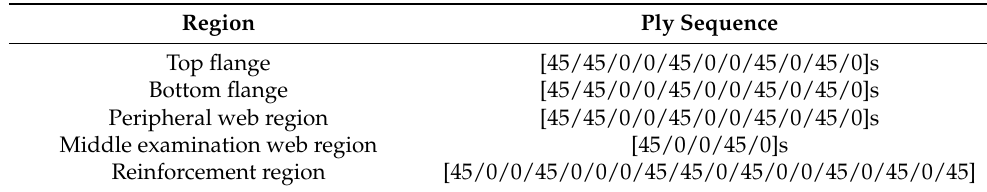
Table 3. Ply sequences of the different regions for the BW-II composite